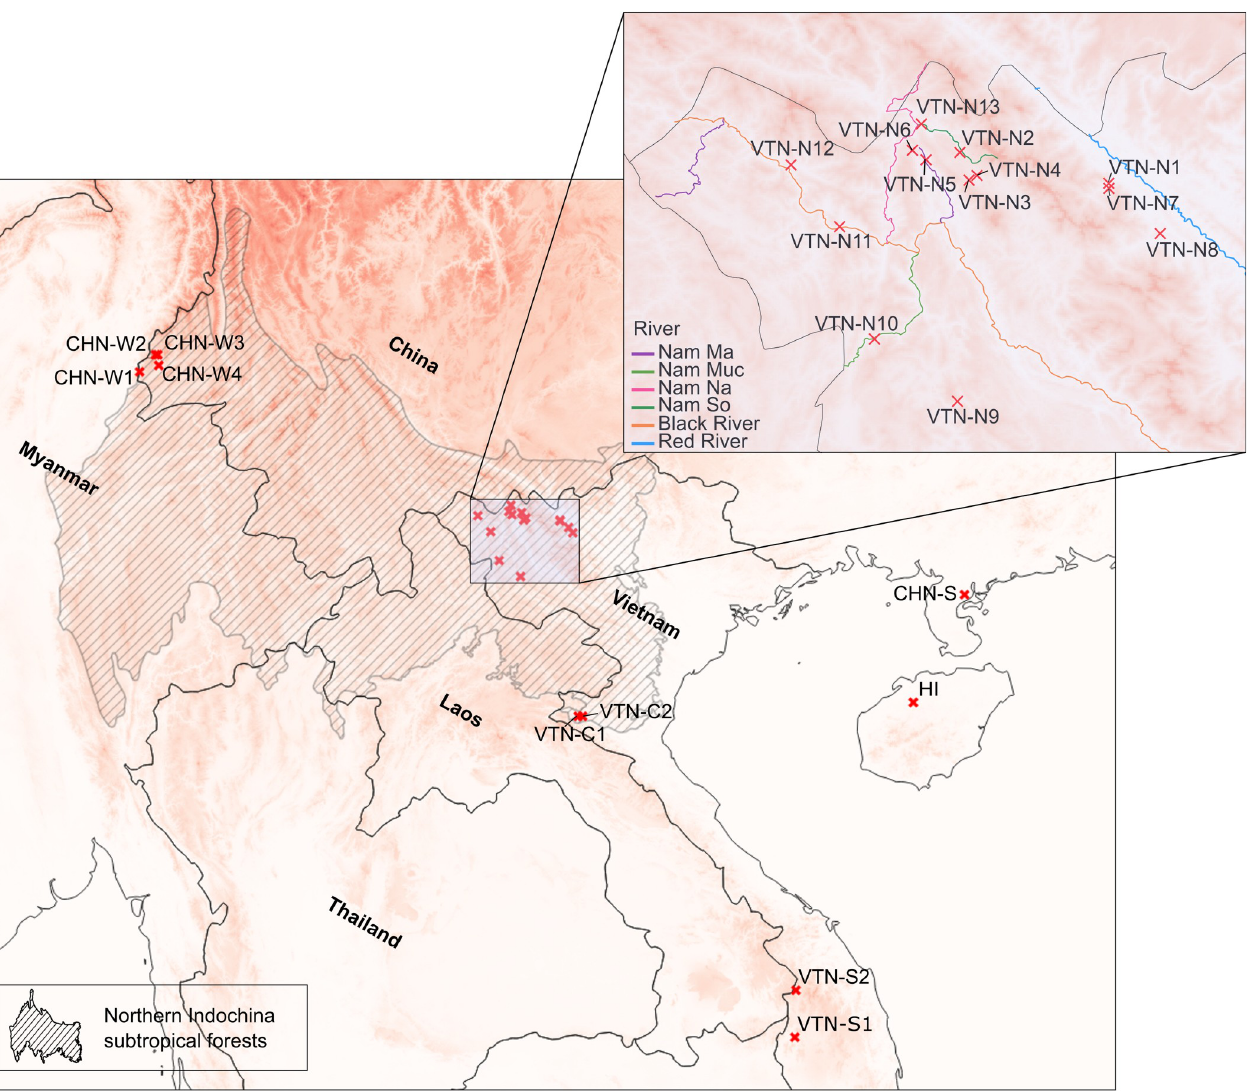
Fig 1. Sampling locations of wild Musa balbisiana populations. Shaded area represents the northern Indochina subtropical forests, the native distribution area of M . balbisiana . Geospatial datasets used for the creation of these maps were reprinted from [59–61] under a CC-BY 4.0 license.